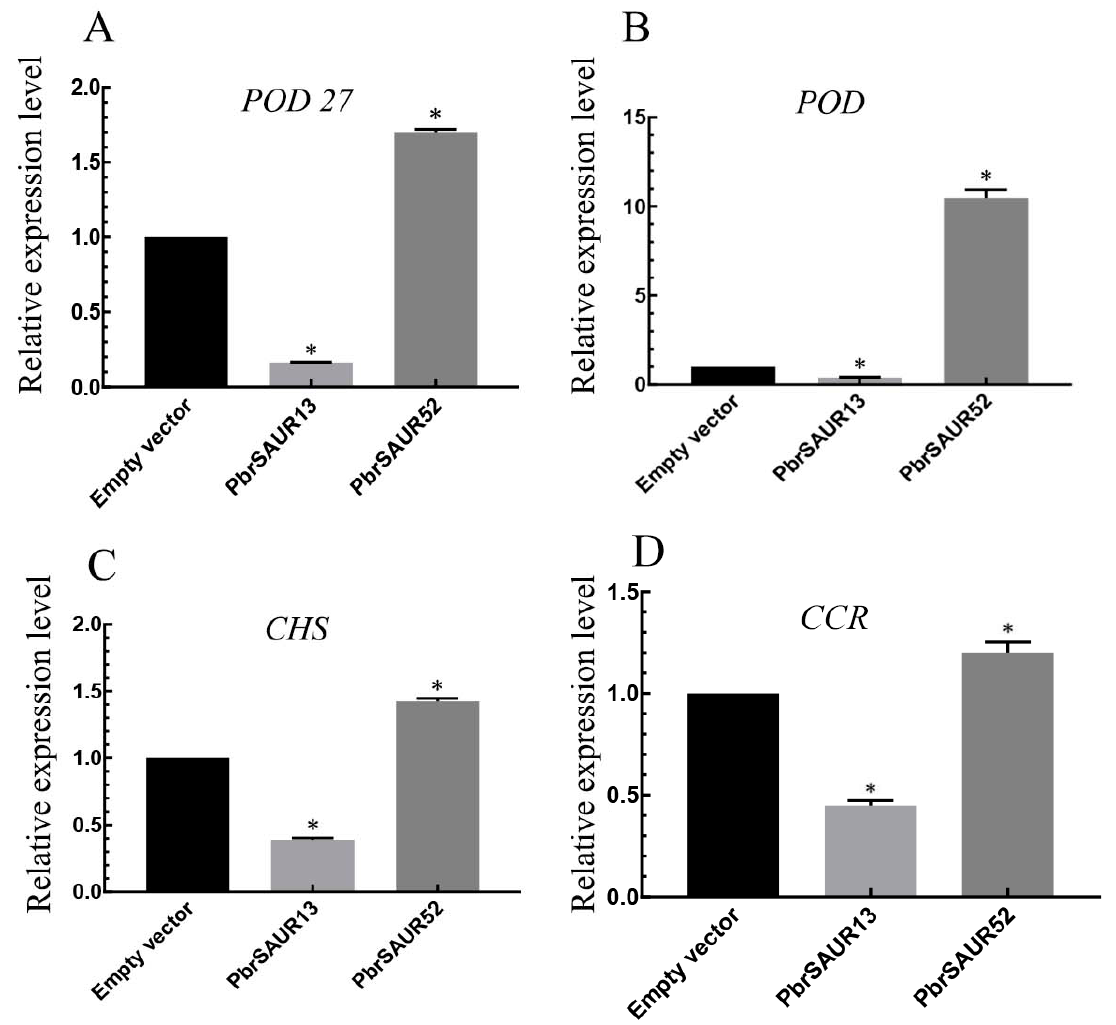
Figure 13. The expression pattern of PbrSAUR13,52 overexpressing in strawberry. * Significant difference at p < 0.05. Key enzyme genes ( A ) POD27 , ( B ) POD , ( C ) CHS , ( D ) CCR of strawberry lignin synthesis